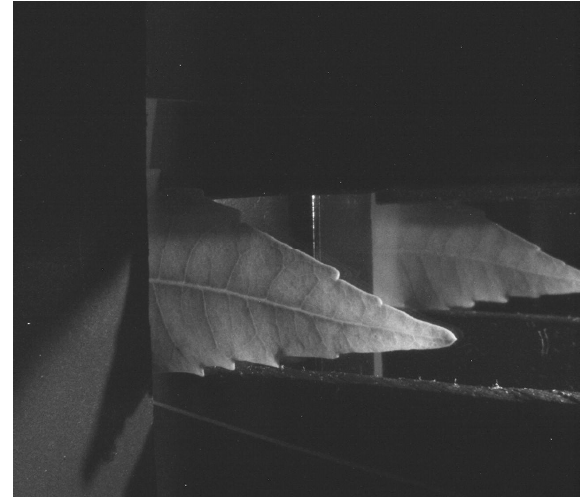
Figure 2. Image of the adaxial and abaxial leaf side in Bayer format.